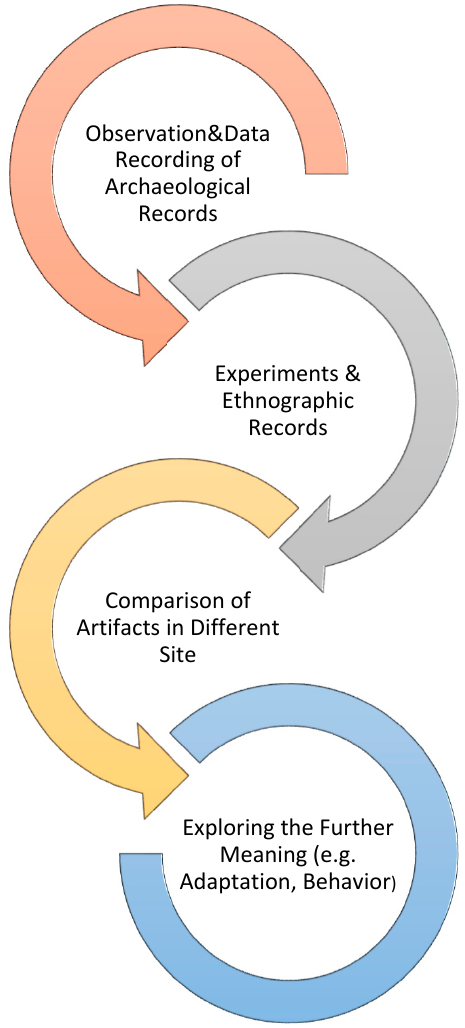
Figure 3. Four steps in lithic